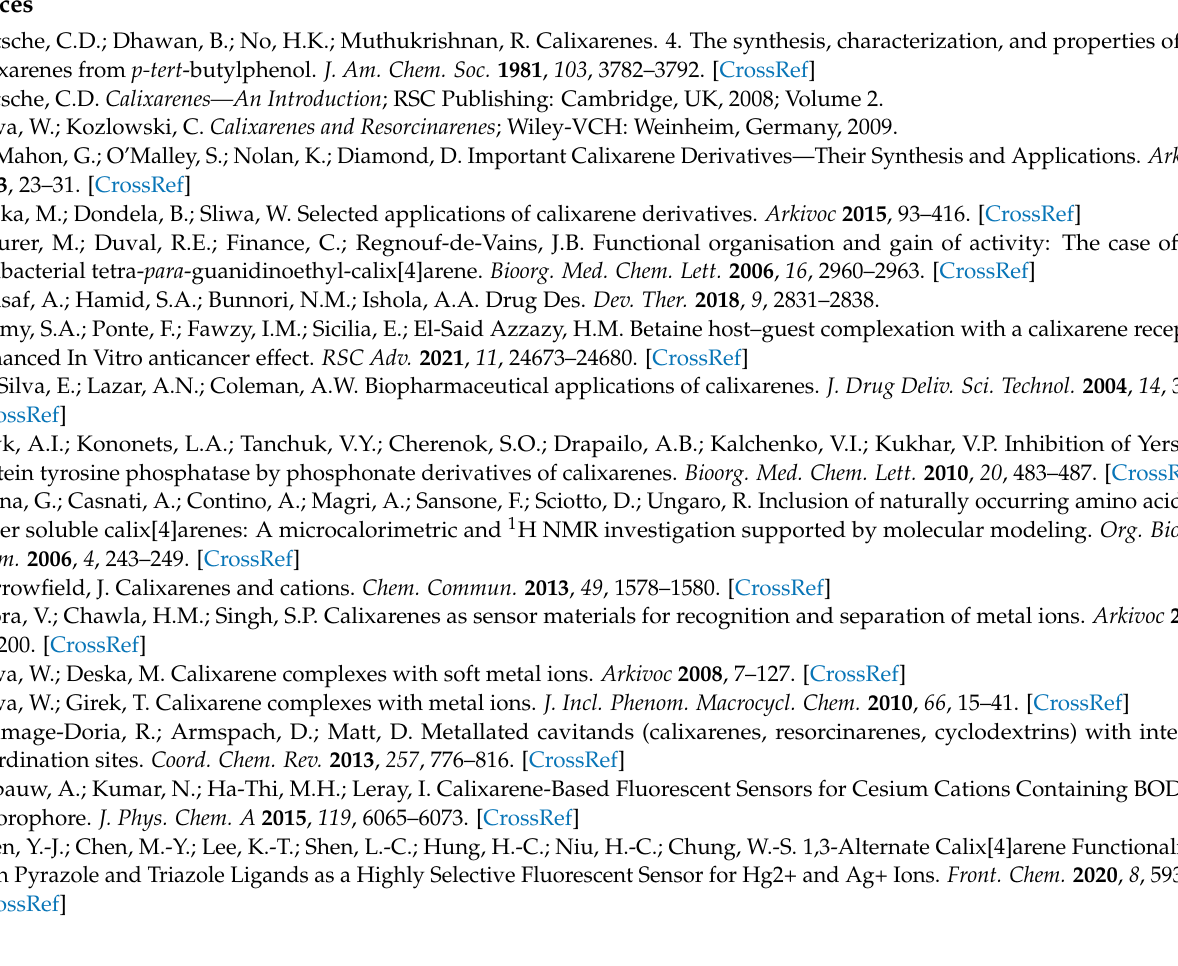
Table S3: The optimized coordinates (in Angstrom) of Ra-calix[4]crown complex calculated using BP86/TZVP, Figures S2–S34: 1 H and 13 C NMR spectra of compounds, Figures S35–S64: UV spectra and UV titration plot of compounds with Ba 2+ , Sr 2+ and Pb 2+